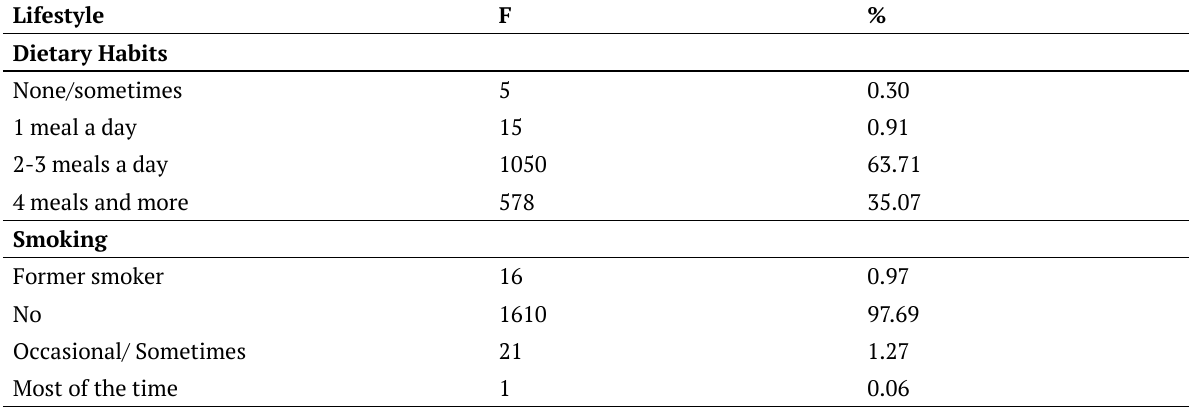
Table 2. Comparative data of the respondents’ lifestyle during the quarantine Lifestyle Dietary